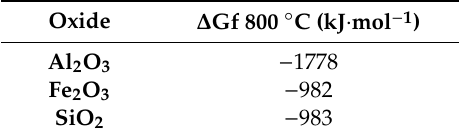
Table 5. Gibbs energy ( ∆ G f ) of formation of oxides at 800 ◦ C